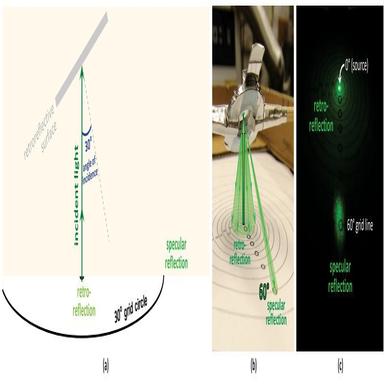
Schematics showing how retroreflection and specular reflection manifest during operation of the simple goniometer (a, b), and example of a light pattern produced by a retroreflective surface (c). The circular grid rings mark angles of specular reflection (which are equal to the angles of incidence) at intervals of 5°. Panel c shows a simple goniometer image of an ASTM D4956 Type 1 retroreflective safety film tilted to obtain an incidence angle of 60°.